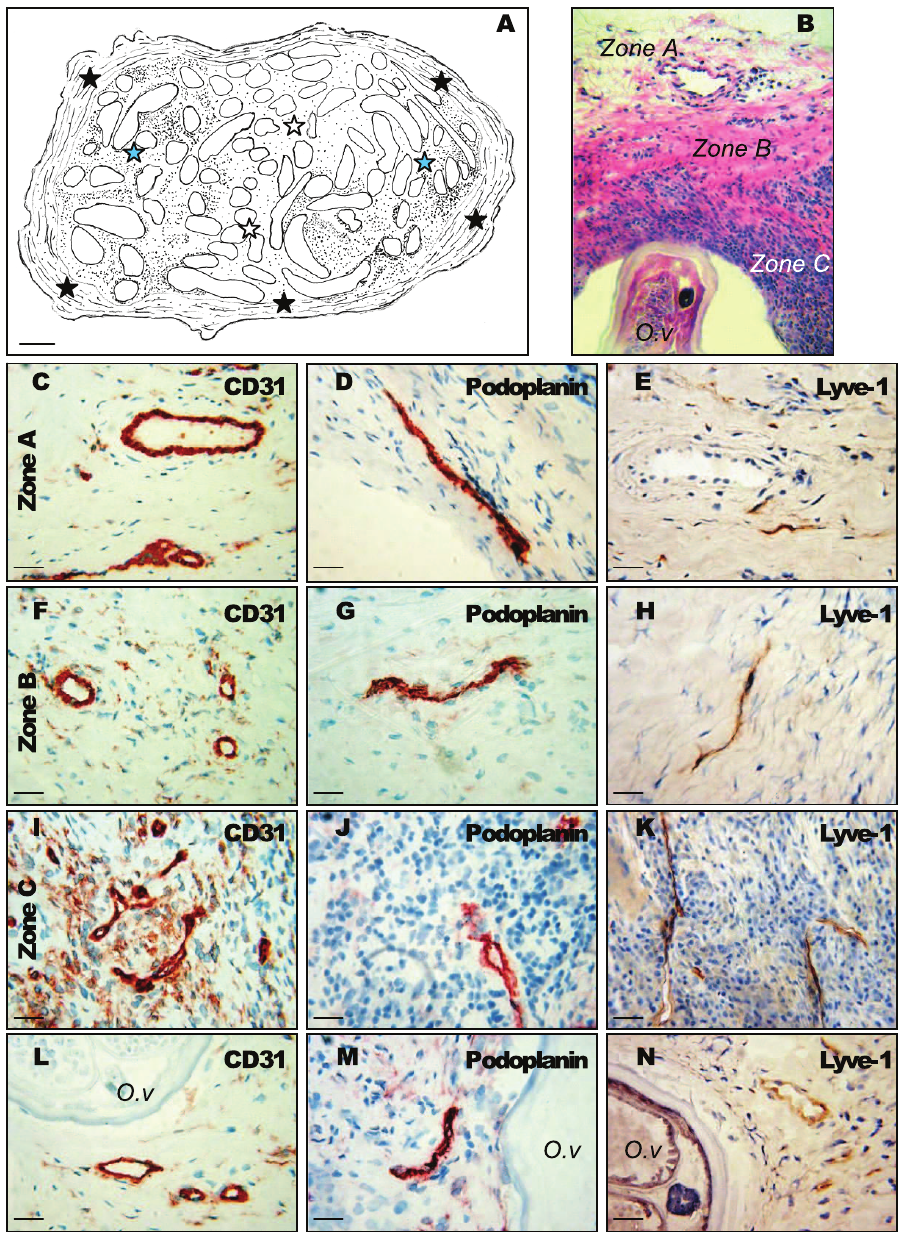
Figure 2. Vascular organisation of onchocercoma. (A) The different zones in nodules: zone A=the outer fibrovascular capsule (black stars), zone B=the inner adult worm bundle with surrounding extracellular matrix interspersed with solitary cells (white stars), zone C=a dense cellular infiltrate surrounding and in contact with the worm (blue stars). (B–M) The blood and lymphatic system in the nodules: sections of onchocerca nodules were stained for CD31 (B, E, H, K) to detect blood and lymphatic vessels, in the zone A (B), in the zone B (E), in the zone C (H), close to a worm section (K) and for Podoplanin (C, F, I, L) in the zone A (C), in the zone B (F), in the zone C (I), close to a worm section (L) or for Lyve-1 (D, G, J, M) in the zone A (D), in the zone B (G), in the zone C (J), close to a worm section (M), to identify lymphatics vessels. Number of analysed nodules=10. O.v. : O. volvulus section. Scales: A, bar=300 m m; B,C,D,E,G,J,K,M bar=25 m m; F,H,I,L, bar=10 m m.